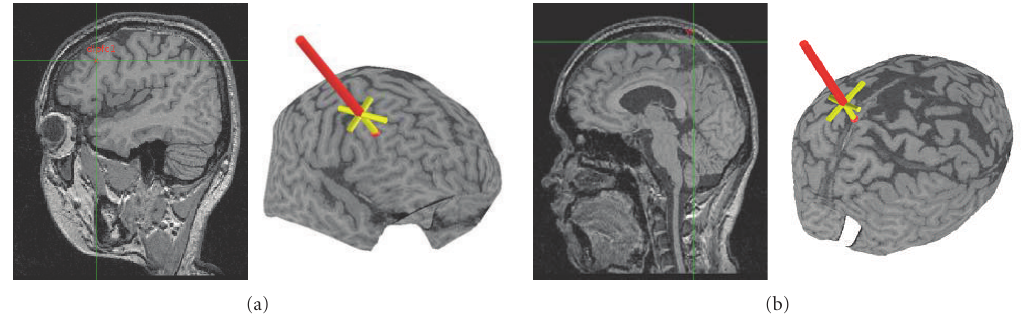
Figure 1: TMS coil was located over (a) the right DL-PFC ( X = 45, Y = 33, Z = 25) or (b) the vertex (control) ( X = 0, Y = − 35, Z = 80). The positioning of the TMS coil over these locations, marked on the native MRI, was performed with the aid of a frameless stereotaxic